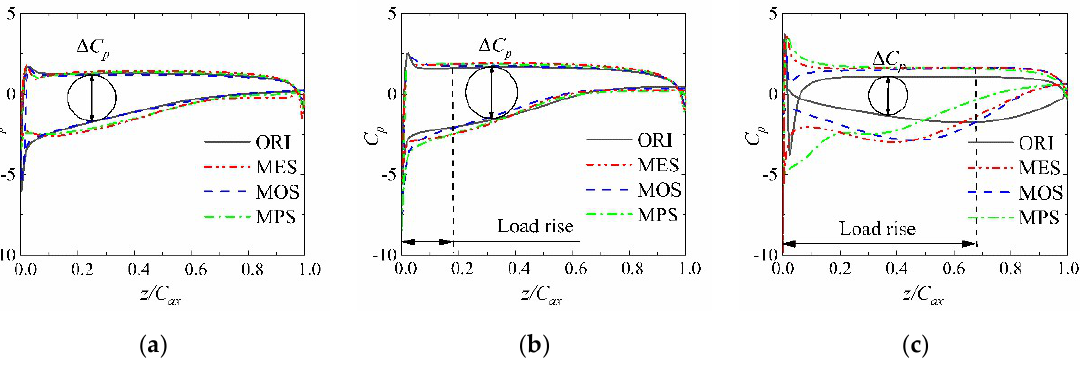
Figure 15. C p distribution in the spanwise sections of 10%, 50%, and 90% span: ( a ) 10% of span; ( b ) 50% of span; ( c ) 90% of span .